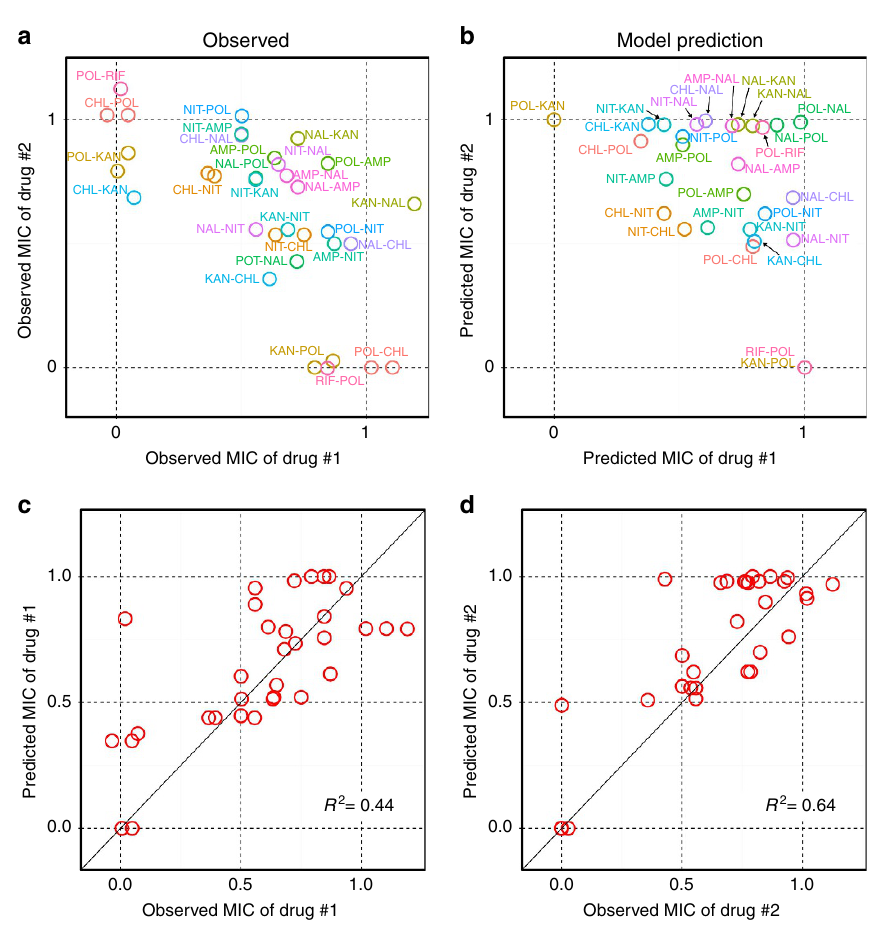
Figure 4 | Comparison of experimental results and model predictions. ( a ) Scatter plot of observed MICs of the first drug against that of the second drug from the final day samples of cycling experiments with 1 day interval. Note that a label for each point indicates the order of antibiotics cycled. For example, KAN-POL means that KAN was used on the first day (denoted as ‘Drug #1’ in the axis label) and POL was on the second day (‘Drug #2’), and then cycled with the order. Due to this notation, KAN-POL and POL-KAN are plotted on the x and y axes, respectively, even though only KAN resistance was developed in both cases (Supplementary Fig. 3a). ( b ) Scatter plot of predicted MICs from the final time point of simulated results. Note that the effect of fitness cost alleviation for NAL and POL cycling was incorporated in the results. ( c , d ) Scatter plots of predicted MICs against observed MICs for the first drug and the second drug, respectively. Note that the same data used for a and b are used